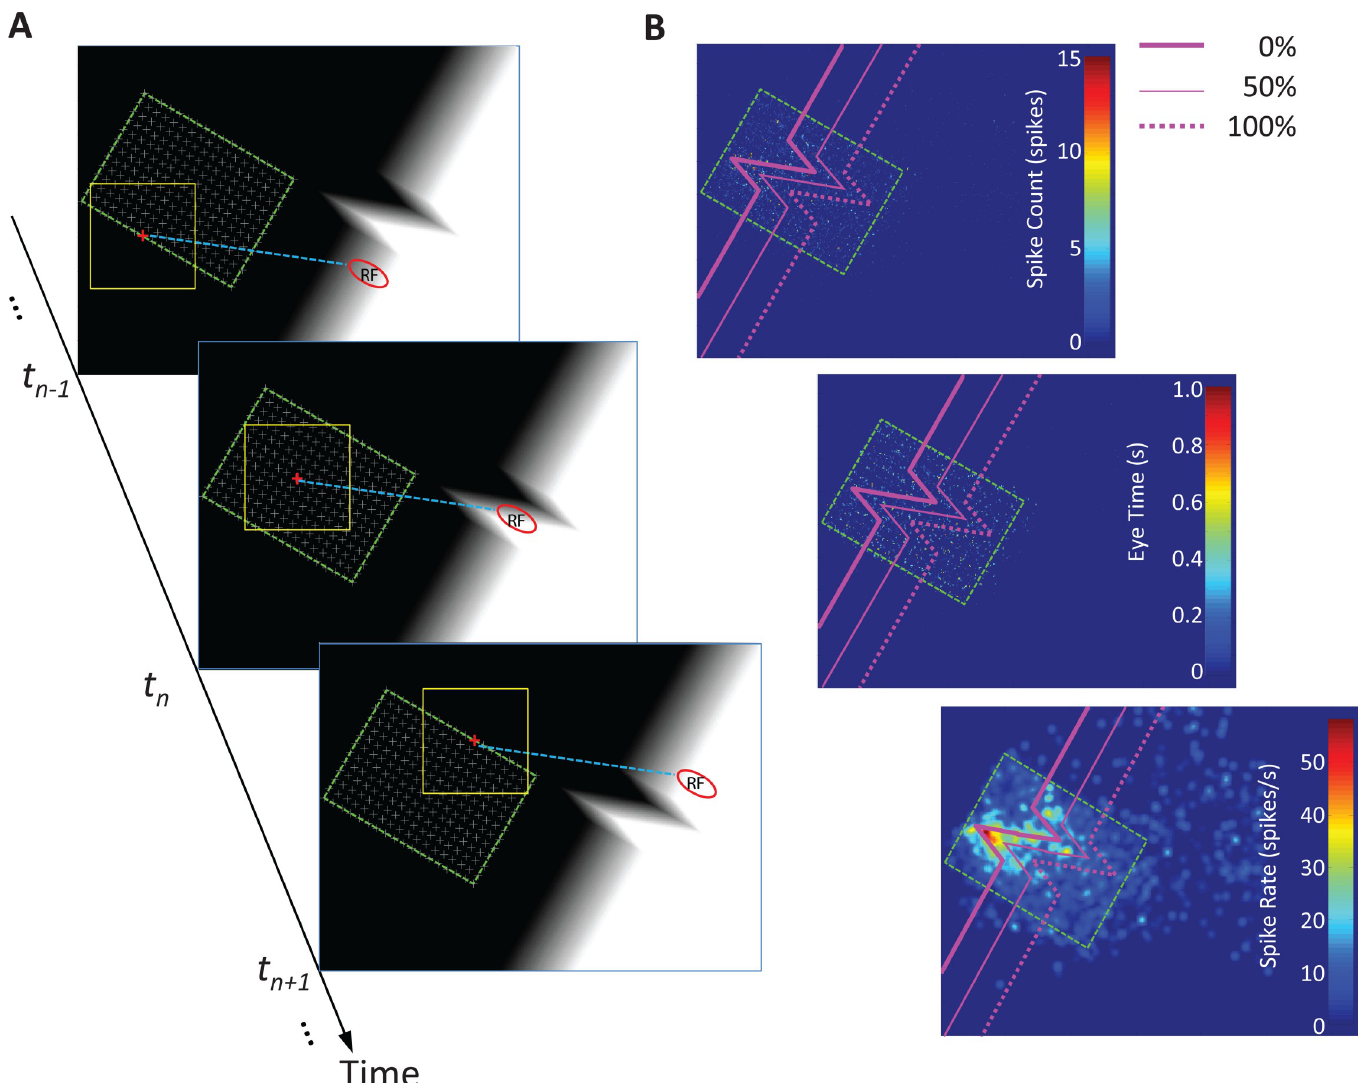
Fig 3. Guided viewing task and the spike rate map. (A) Guided viewing. We rotated the visual stimulus to align specific features with the neuron’s preferred orientation (see Materials and Methods for details) in each experimental condition. The green dashed rectangle shows the fixation grid’s boundary. The grid, indicating the candidate positions of the fixation cross, was placed according to the eccentricity of the neuron’s RF. When the monkey fixated his gaze at the grid center, the RF was centered on the visual stimulus (red dots in Fig 2 ). The area of the grid was equal to or slightly larger than each visual stimulus’ ROI. A 2x2 DVA (32 x 32 DU) window (indicated by the yellow square and invisible to the monkey) surrounded the fixation cross (see Materials and Methods for details). When the monkey’s gaze was guided to different fixation cross locations, the RF (indicated by the red oval) covered different regions of the visual stimulus. (B) Spike rate map. The green dashed rectangle shows the fixation grid’s boundary (as in (A)). We registered RF positions to different regions of the visual stimulus according to the neuron’s eccentricity and the estimated retina-to-V1 latency. (In other words, we were able to determine what regions of the visual stimulus had stimulated a neuron’s RF at any given time based on that RF’s eccentricity and the estimated latency of the neuron’s responses). Then, we constructed the Spike Count Map by counting the number of spikes that occurred at each image elementary unit (i.e. DU) (top panel). We also constructed the Eye Time Map, i.e. the total time in seconds the eye spent at each image elementary unit (middle panel). Subsequently, we estimated the spike rate map at each image elementary unit by dividing the spike count by the Eye Time. The resulting 2D image was subsequently smoothed with a symmetric 2D Gaussian filter (size of 1 DVA (16 DU) and STD of 0.44 DVA (7DU)) to yield the Spike Rate Map (bottom panel). the neuron’s RF was located on different parts of the visual stimulus. Neural activity was regis- tered to different parts of the stimulus according to the RF eccentricity and the estimated latency between retina and V1 (set at 60 ms, see “Spike rate and spike rate difference map” and “Conduction latency” sections for details. The minimum number of spikes required to